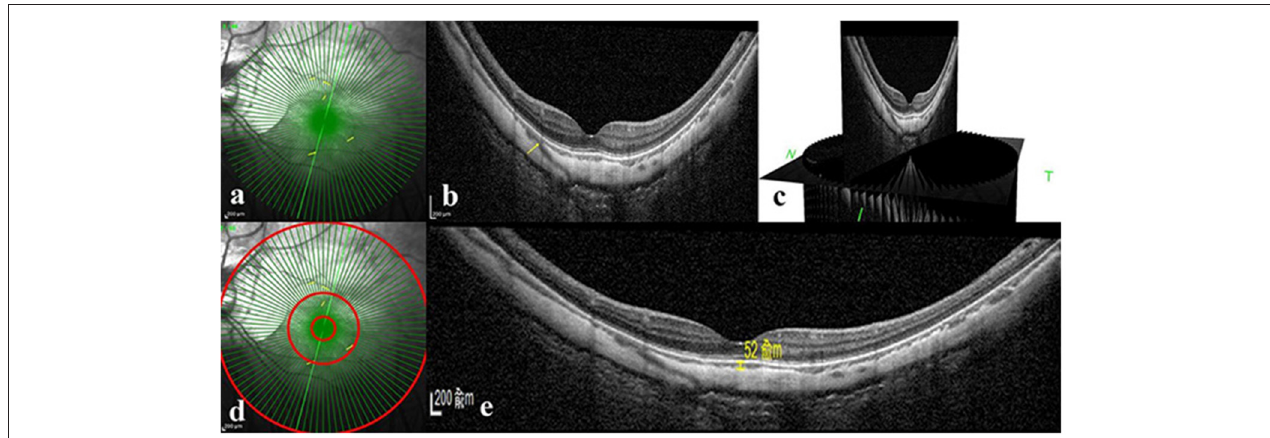
FIGURE 1 | Perforating scleral vessel counting method and macular choroidal thickness assessment using spectral-domain OCT. (a) Structural OCT en face image of one patient. Enhanced depth OCT scanning was centered on the macular with 48 radical scans, a length of 9mm and an A-scan repeat time of 9. (b) B-scan image corresponding to the scan line of the green arrow in part a. The yellow arrow in parts a and b indicates the corresponding position where PSV entered the choroid from the sclera. (c) Three-dimensional reconstruction picture of B-scan image based on Heidelberg software. (d) Counting of PSV in three different regions, such as 1 diameter circle, 3 diameter circle, and 9 diameter circle. (e) Structural OCT scan through the fovea. Macular choroidal thickness is measured in a 1:1 µ m image using Heidelberg software (shown as a yellow line segment of 52 µ m). OCT: optical coherence tomography.